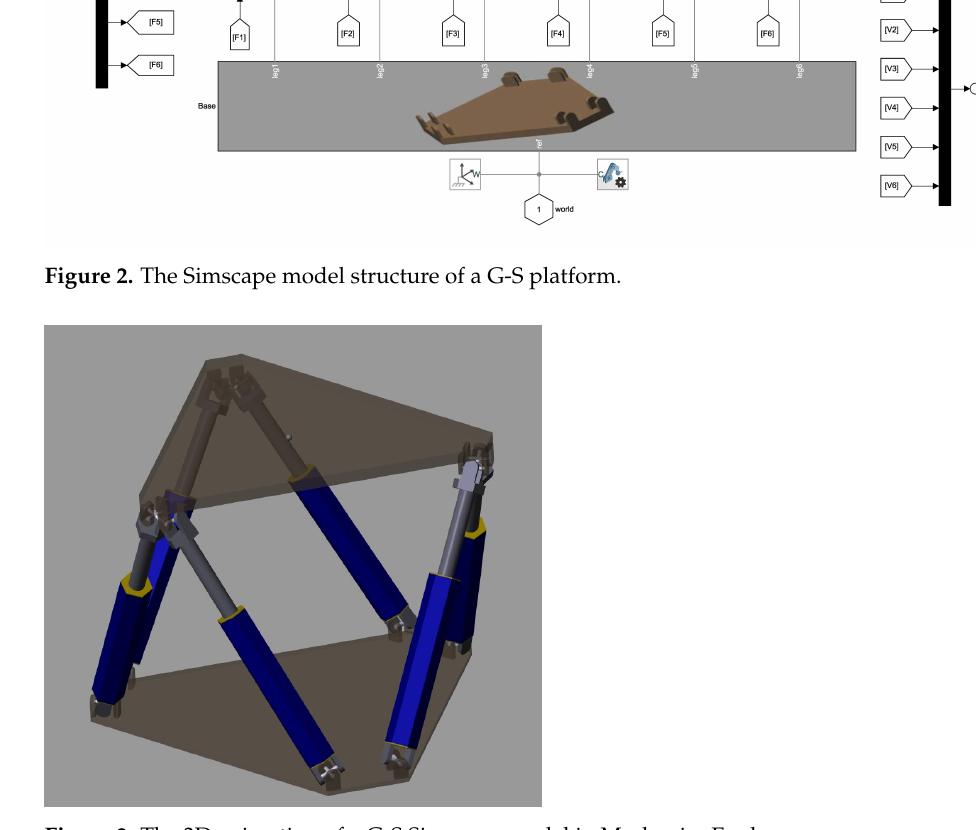
Figure 3. The 3D animation of a G-S Simscape model in Mechanics Explorer.